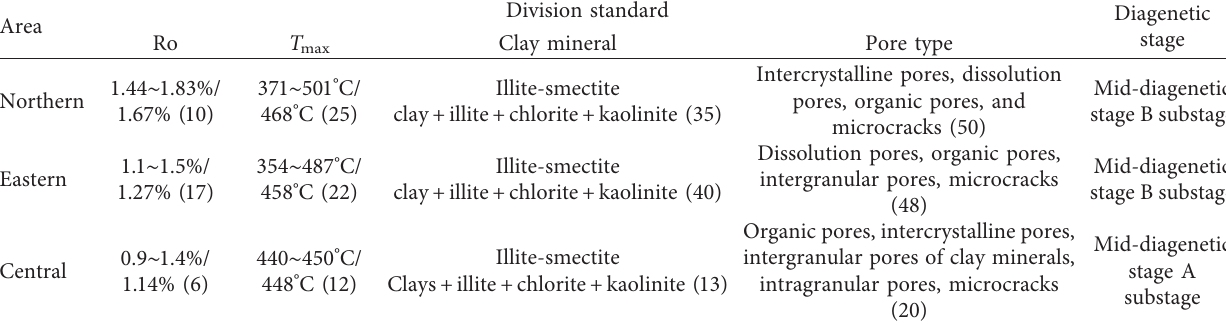
Table 4: Division basis of diagenetic stage of Da’anzhai member in Sichuan Basin.